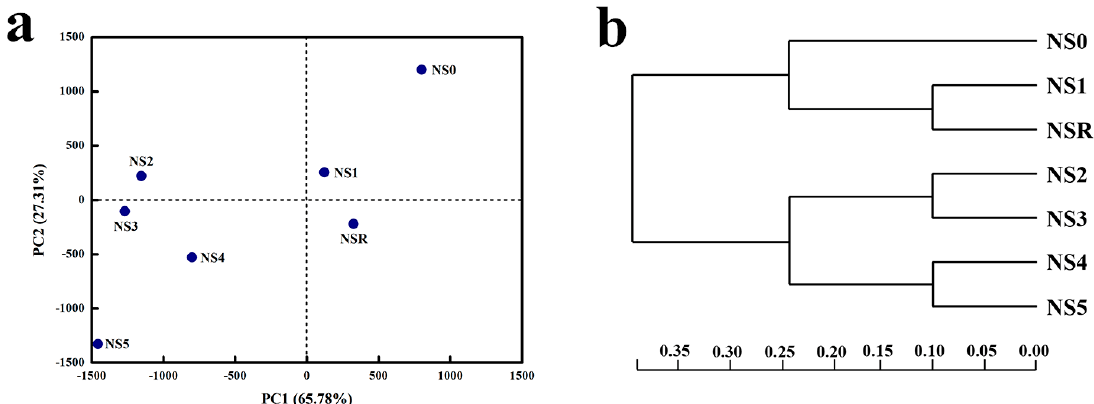
Figure 4. Principal coordinate analysis (PCoA) and cluster analysis for the similarity analysis of nitrification sludge samples at different Cr (VI) concentrations: ( a ) PCoA; ( b ) cluster analysis.